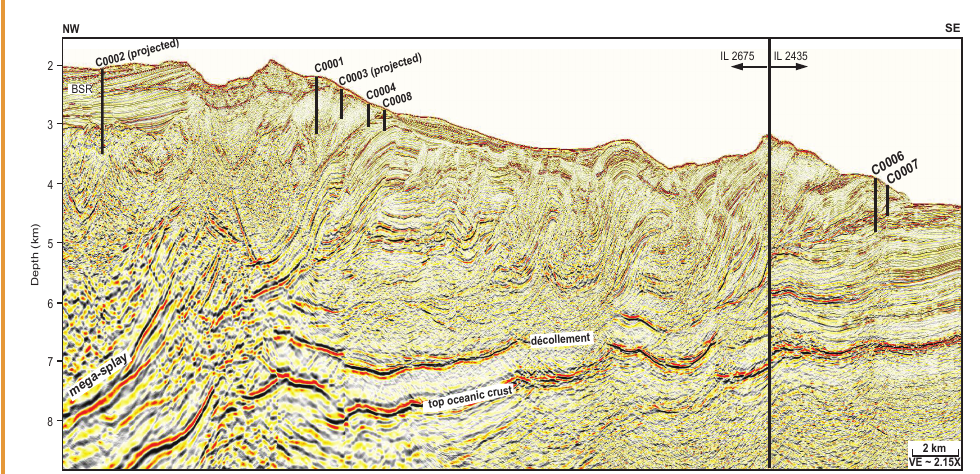
Figure 2. NW-SE slice through the NanTroSEIZE 3-D seismic survey (composite of 3-D Inlines 2435 and 2675) showing the projected locations of the sites, cored and logged during Stage 1. (Moore et al.,